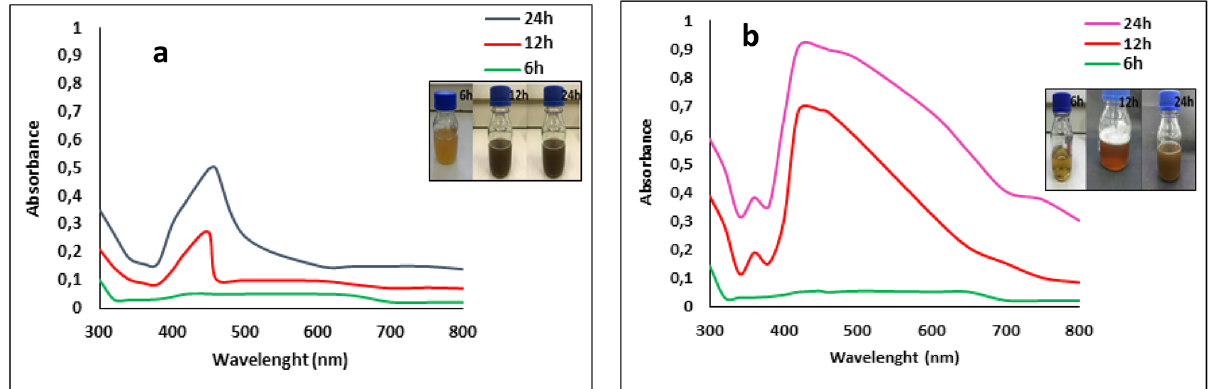
Figure 1. UV–vis spectra of biosynthesized AgNPs recorded at time intervals 6, 12 and 24 h. (a) AgNPs obtained with supernatant from non-exposed cultures (AgNPs CONTROL ), (b) AgNPs obtained with supernatant from SMF-exposed cultures (AgNPs SMF). Inset to (a,b) ; the intensity of yellow to brown color change increases with time (6 h, 12 h and 24